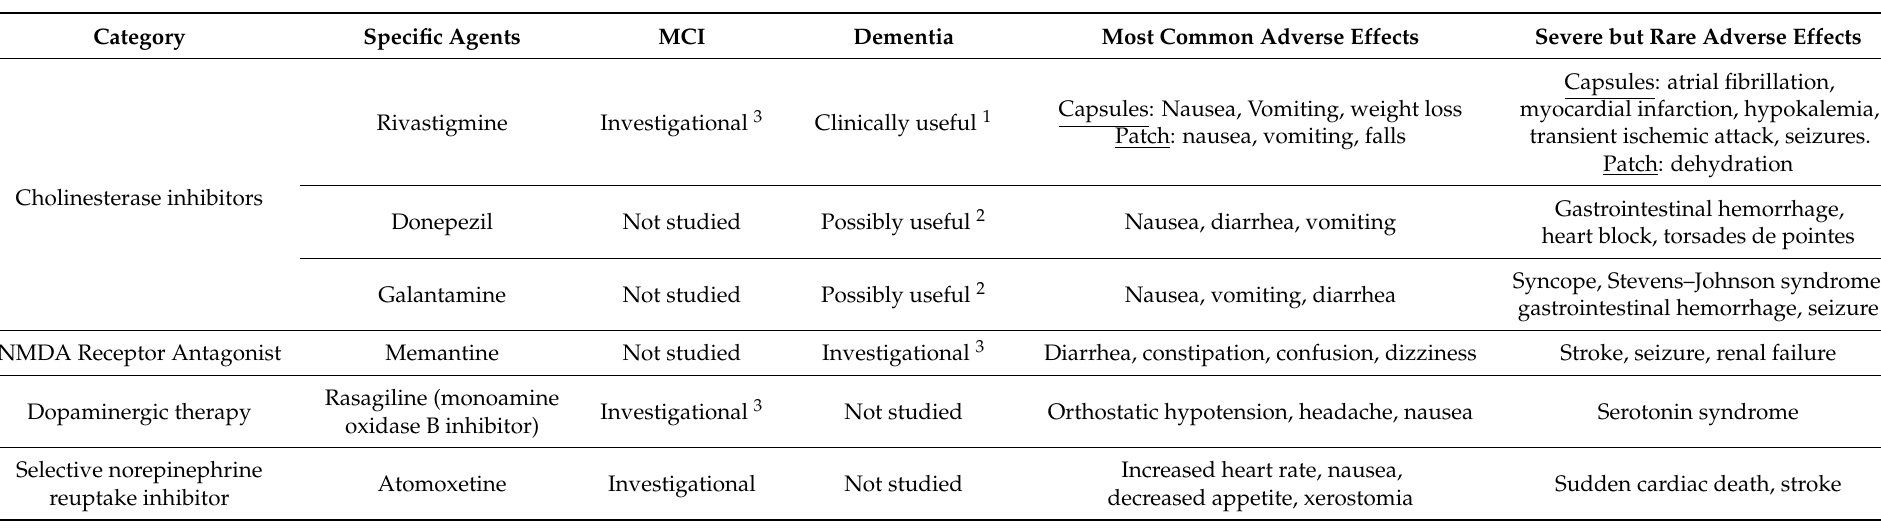
Table 2. Clinically available pharmacologic treatments for cognition in Parkinson’s disease mild cognitive impairment and Parkinson’s disease